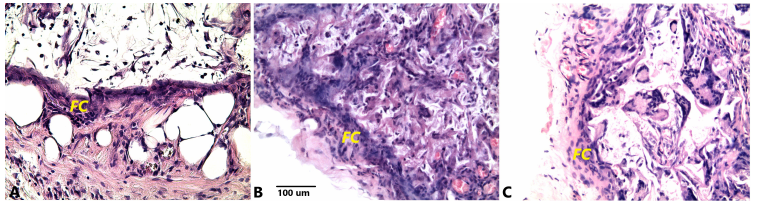
Figure 5. Histological evaluation of tissue reaction to scaffold-1 subcutaneous implantation on 7th ( A ), 14th ( B ), and 60th ( C ) days. The yellow mark FC shows the fibrous capsule formation. Hematoxylin- eosin staining; × 200. Original microphotographs (A, B, and C) in good resolution are presented in Supplemental images for Figure 5. Histological evaluation of tissue reaction to PHB films as Control is presented in Supplemental Materials, Figure S3.